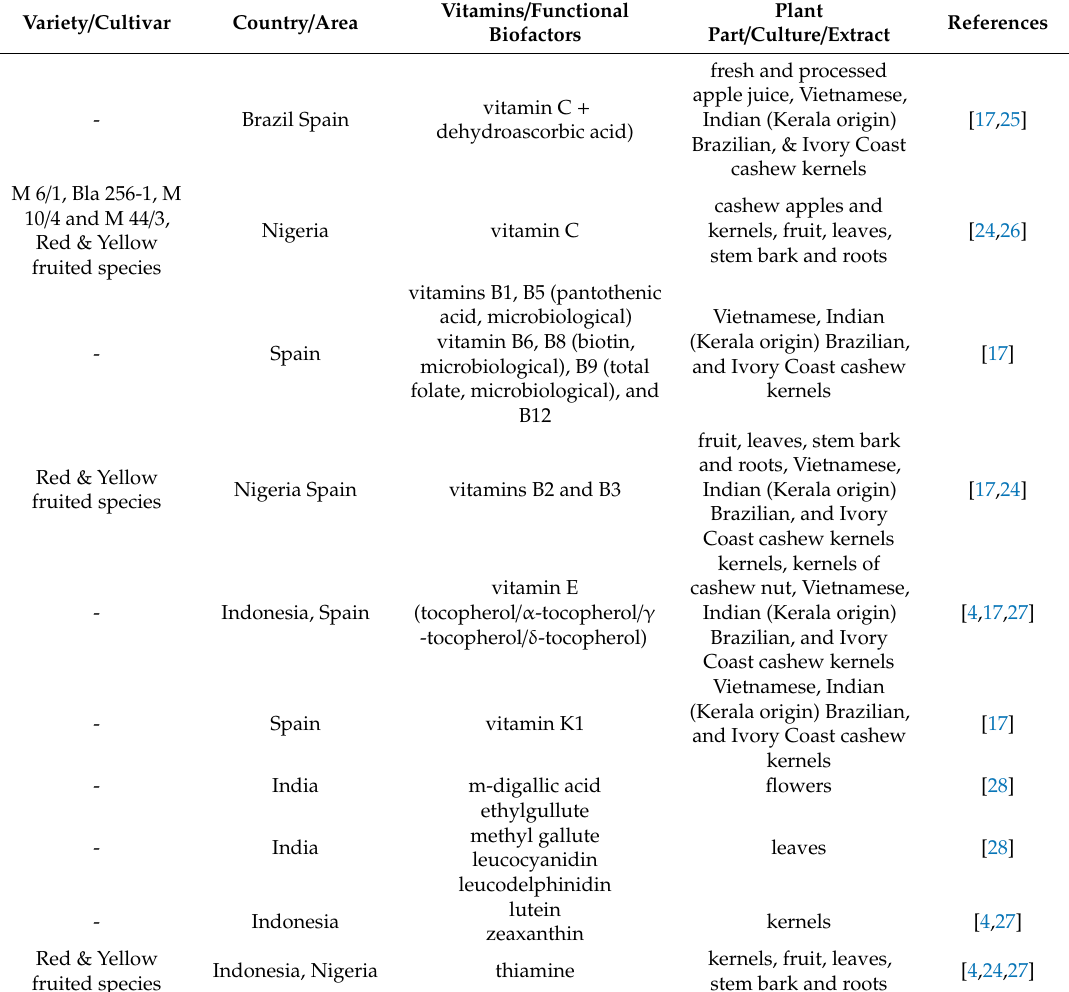
Table 2. Vitamins and functional biofactors present in Anacardium occidentale .